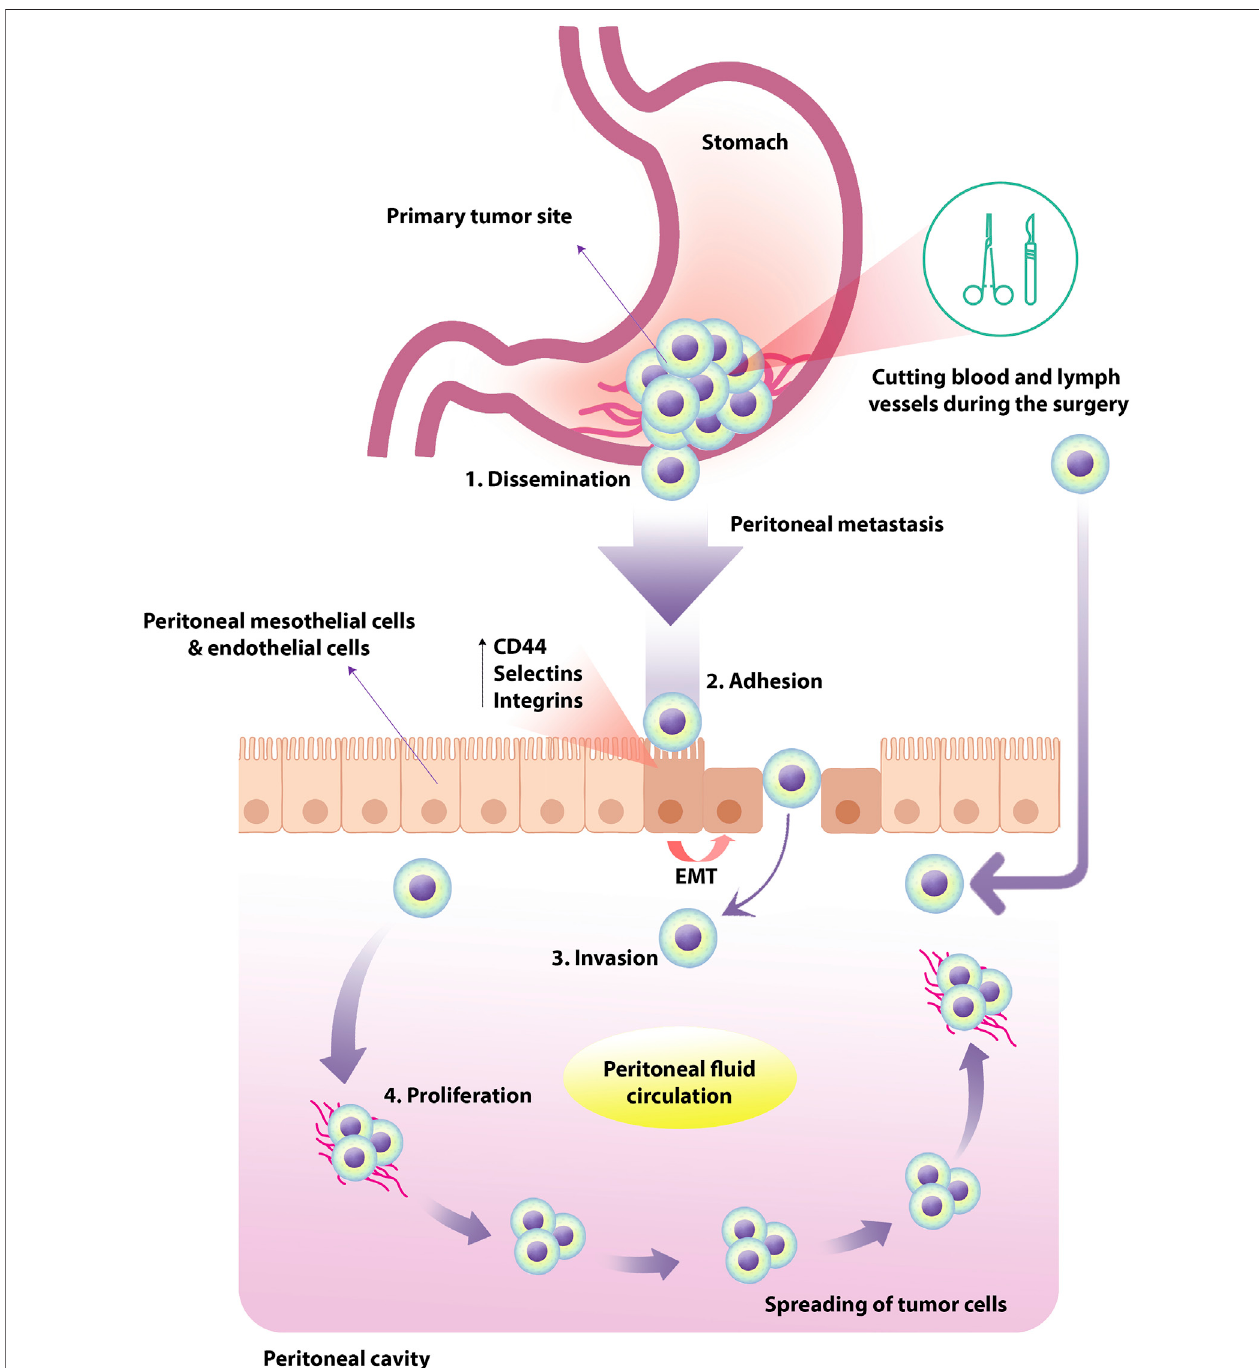
FIGURE 1 | Peritoneal metastasis of tumor cells in human GC. Primary tumor cells originate from the primary abdominal organs and spread through the transcolumicmechanism.Thespeci fi ctypeanddirectionofperitoneal fl uidcirculationcanleadtothetumorcellsspreadinginaparticularorder.InhumanGC,PMoccurs in four steps; dissemination, adhesion, invasion, and proliferation. The expression of TGF- β 1, leukocyte-associated adhesive molecules such as CD44, selectins and integrins could up-regulate by peritoneal mesothelial cells and endothelial cells, resulting in EMT of peritoneal mesothelial cells. Tumor cells exfoliate from the primary tumor into the peritoneal cavity in the more common transverse growth method, regularly occurring before surgery. In the intraperitoneal spread due to surgical injury, malignant cells are inadvertently released and spread through the peritoneum by manipulating the primary tumor, cutting blood and lymph vessels during the operation. GC, gastric cancer; PM, peritoneal metastasis; TGF- β 1, transforming growth factor-beta1; EMT, epithelial-mesenchymal transition.